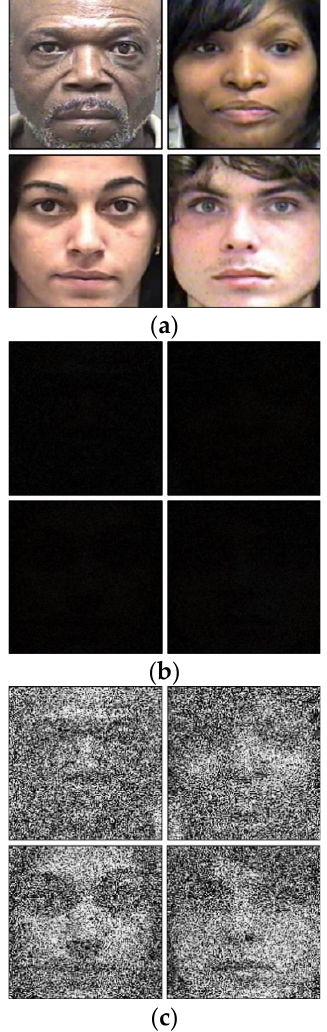
Figure 5. Examples of original and generated facial images. ( a ) Original images, ( b ) corresponding generated facial images in low illumination, and ( c ) corresponding histogram-equalized facial images in low illumination.